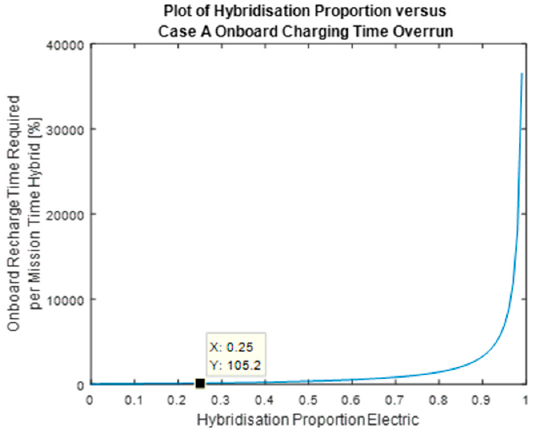
Figure 6. Hybridisation proportion vs. Case A charge time over-run; multiple EPS.